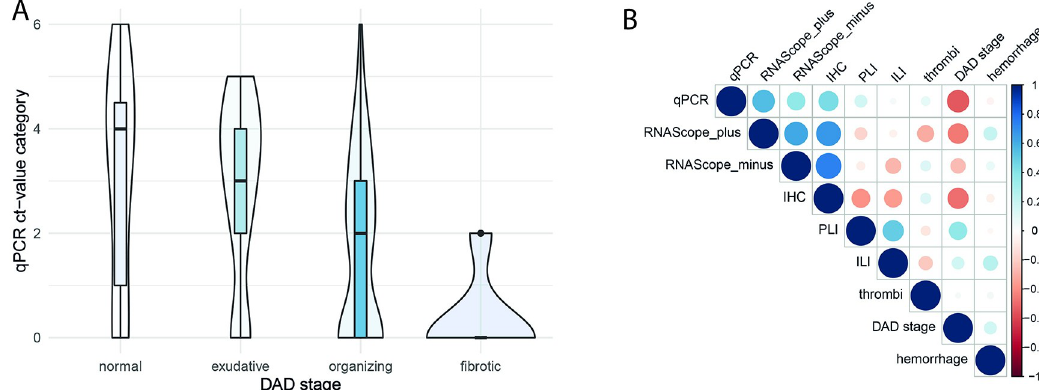
Fig 4. A) Correlation of DAD stage and RT-qPCR Ct values (Boxplot/Bean-plot) and B) Correlation of histological lung changes and RNA-detection with RT-qPCR and RNA-ISH and IHC on a sample basis. DAD = diffuse alveolar damage, qPCR = real-time quantitative polymerase chain reaction, ct = cycling threshold, IHC = immunhistochemistry, PLI = perivascular lymphocyte infiltration, ILI = interstitial lymphocyte infiltration.